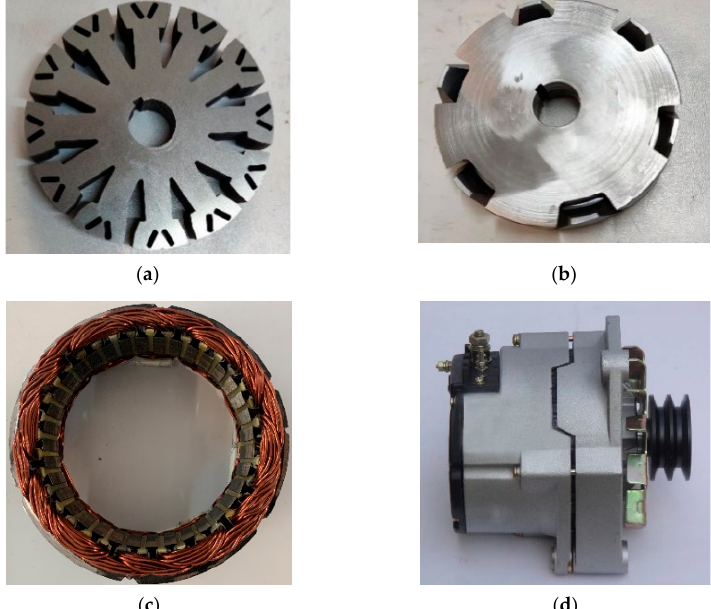
Figure 23. Compound excitation generator prototype. ( a ) Salient-pole rotor core; ( b ) PM claw pole rotor core; ( c ) stator; ( d ) generator.